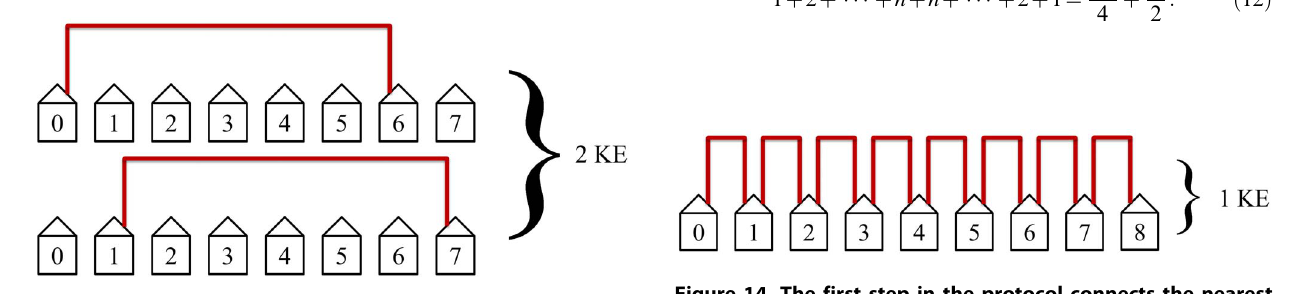
Figure 12. The sixth step in the protocol connects the sixth nearest neighbors. This step requires only 2 KEs since there are only two possibilities.